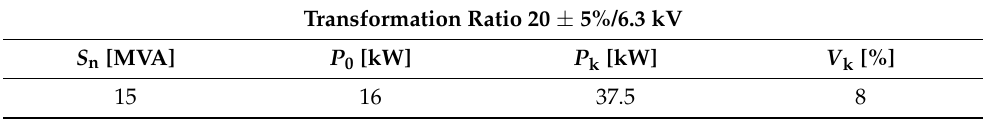
Table 7. Electrical data of the MV/MV transformers.